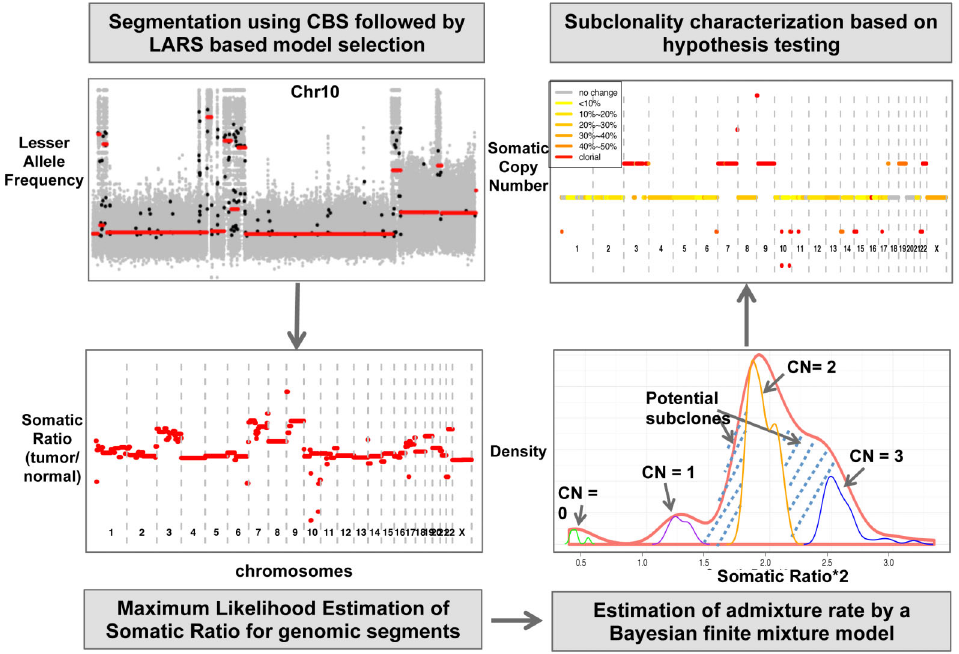
Figure 1. Overview of SomatiCA framework. First, SomatiCA segments the genome and identifies candidate CNAs utilizing both read depths (RD) and lesser allele frequencies (LAF) from mapped reads. Second, SomatiCA estimates the admixture rate from the relative copy-number ratios of a tumor-normal pair by a Bayesian finite mixture model, which has high tolerance on contamination from normal cells. Finally, SomatiCA quantifies somatic copy-number and subclonality for each genomic segment to guide its characterization.